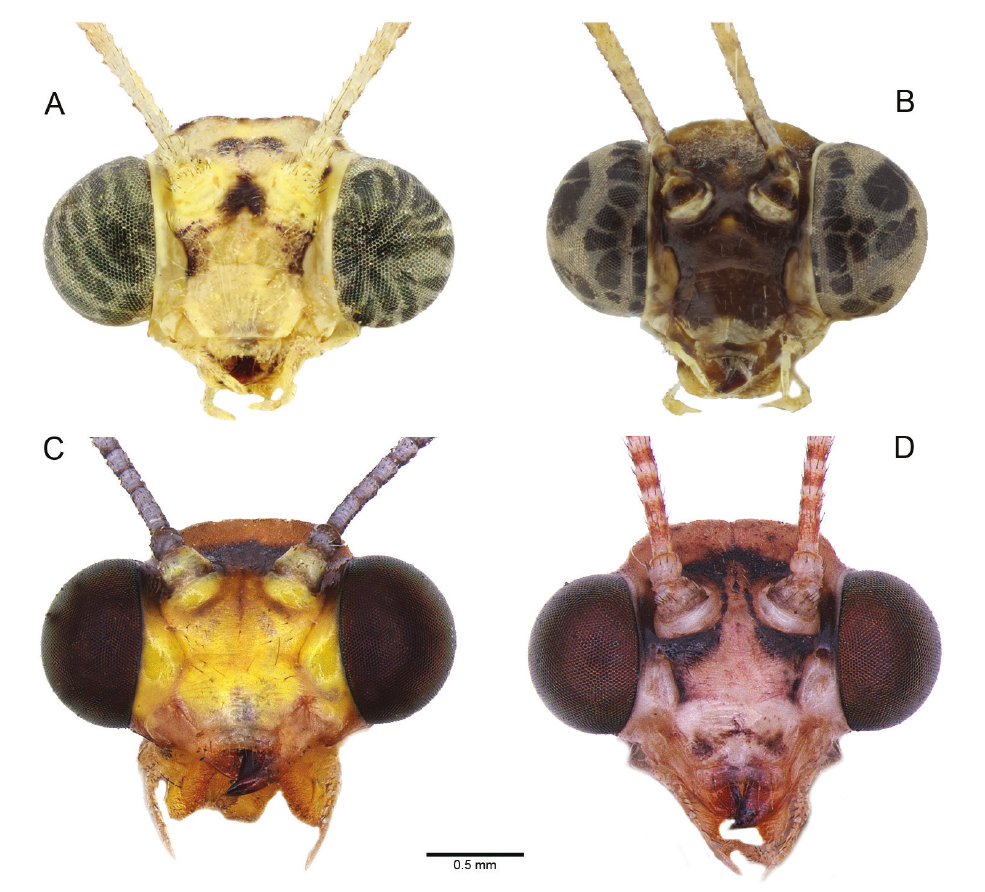
Figure 3. Head of Gymnocnemia and Megistopus , frontal view. A Gymnocnemia variegata [Italy, Sardinia]; B Gymnocnemia mira - bilis [Oman, Jabal Shams]; C Megistopus flavicornis [France, Gard]; D Megistopus lucasi [Italy, Sardinia]. leg covered with white outstanding setae, similar to those on thorax, arranged in a comb-like row (Fig.